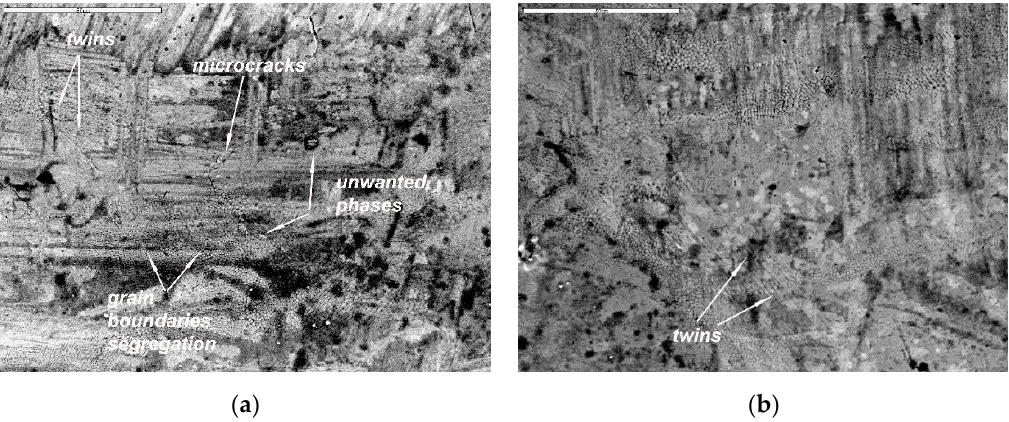
Figure 9. Microstructure of the cut material, shown by scanning electron microscopy: ( a ) before optimization; ( b ) after optimization. Bars in the upper left corner denote 50 µm.